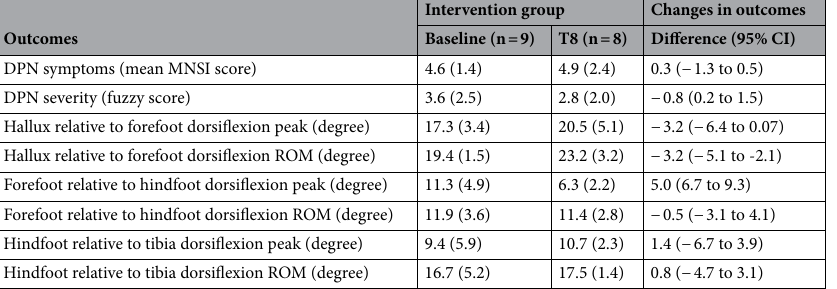
Table 2. Clinical outcomes and foot–ankle kinematics during gait of the intervention group and within-group difference (baseline to Week 8 (T8)). Data are presented as mean (SD) and differences with 95% confidence